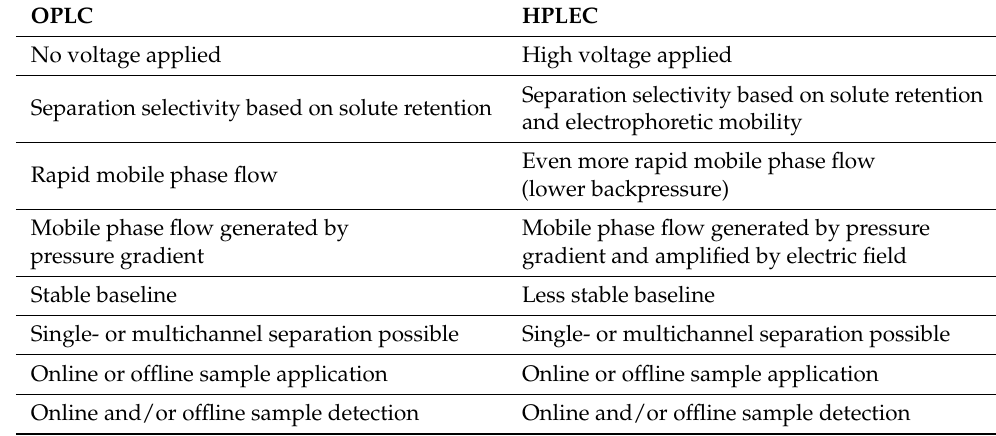
Table 1. Comparison of OPLC and HPLEC techniques.